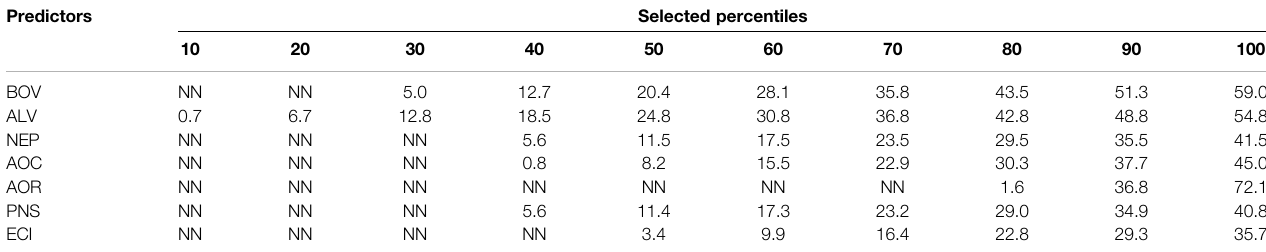
TABLE 6 | Bottleneck analysis for energy conservation behaviour.